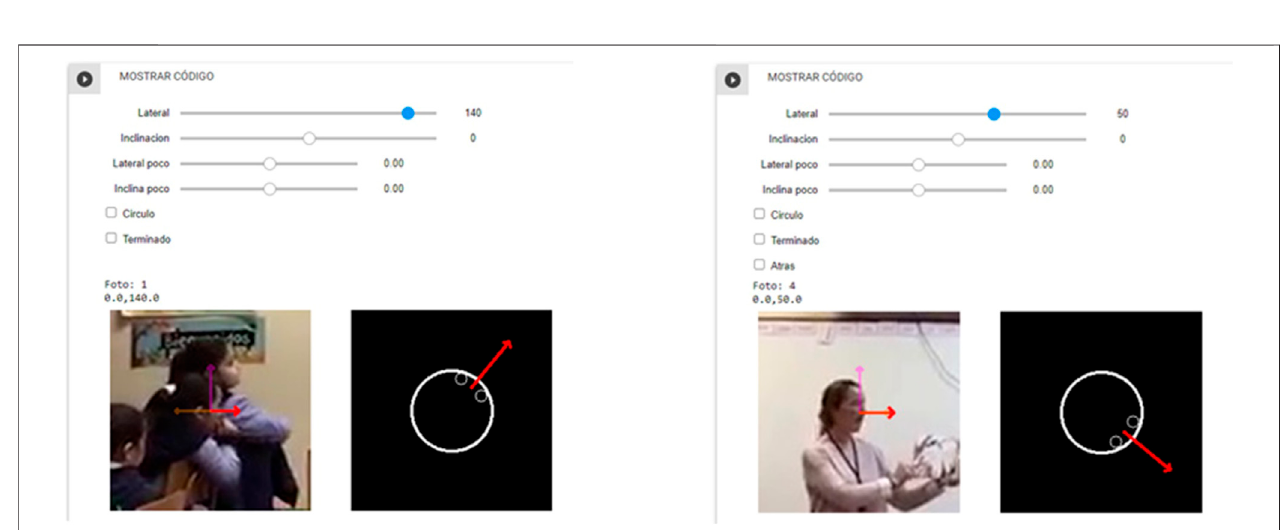
FIGURE 3 | Yaw and pitch angles of the head, and yaw and pitch angles of the body at chest height. (A) : Yaw and pitch angles of the head. (B) : Yaw and pitch angles of the body at chest height.